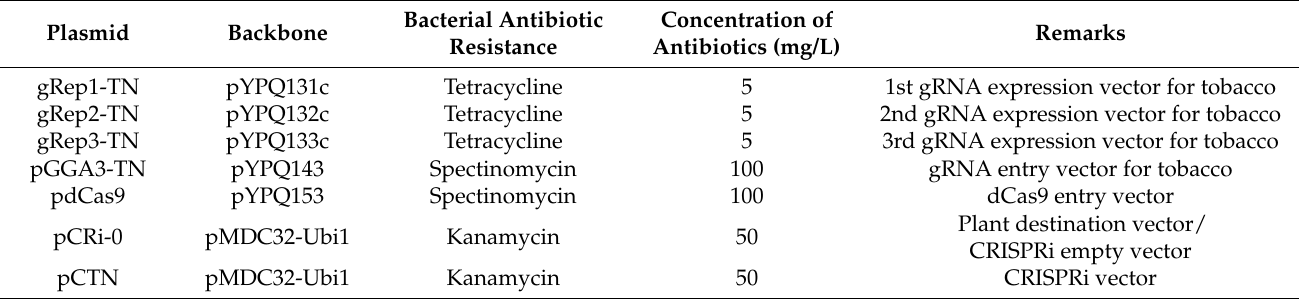
Table 1. List of plasmids for Escherichia coli transformation.